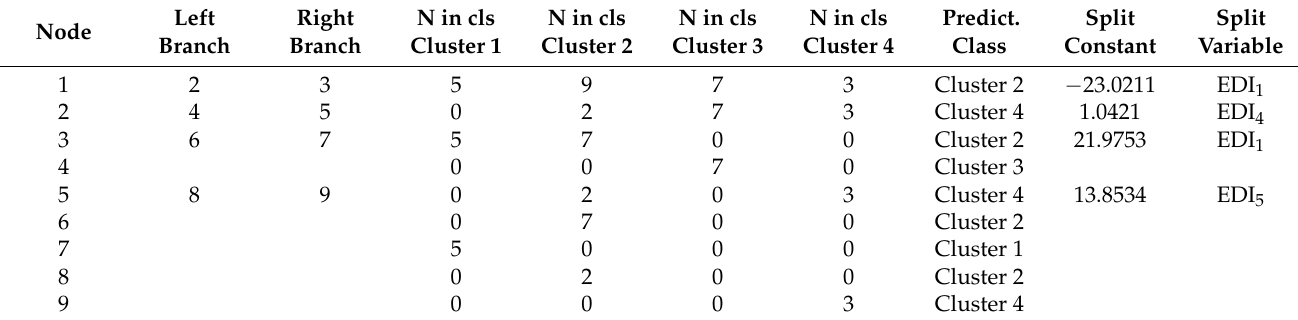
Table 10. Classification tree structure according to the scenarios of sustainable energy development modeling.